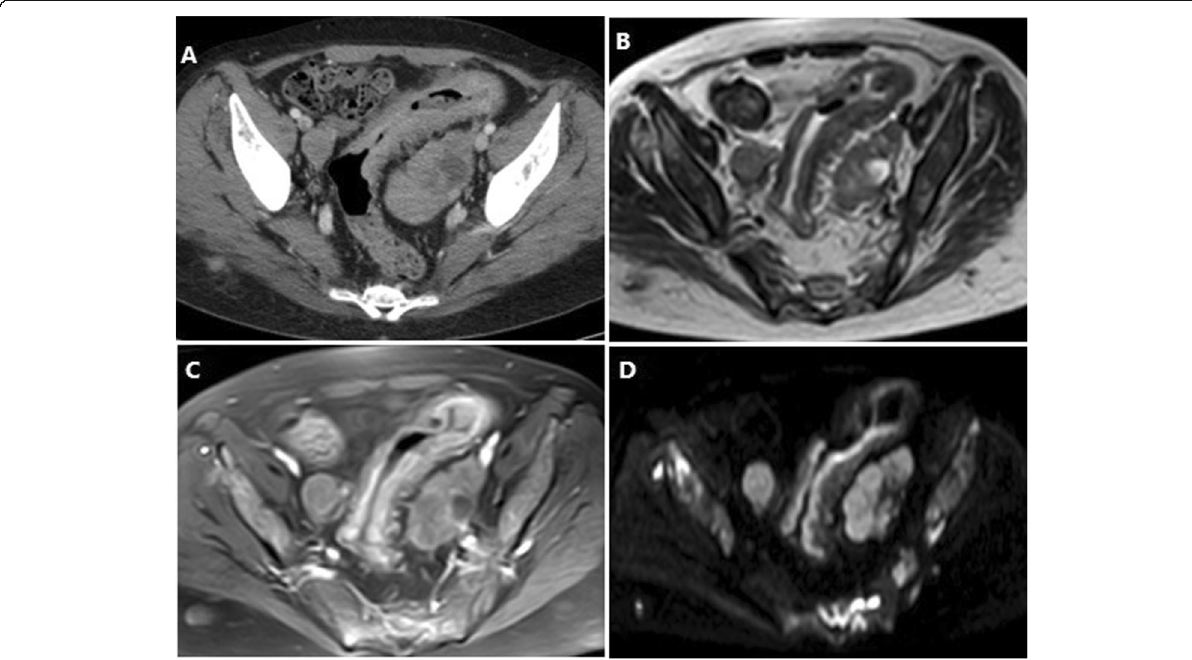
Fig. 2 a Axial post-contrast CT pelvis, b axial T2-weighted image, and c post-contrast T1-weighted image revealed diffuse asymmetrical circumferential thickening of the rectosigmoid with stranding of related fat planes and bilateral predominantly solid complex heterogeneously enhanced ovarian masses, larger on the left side (Krunkenberg tumor). d Axial diffusion-weighted image (DWI) revealed multiple diffusion restricted infiltrative bony deposits at both the iliac bones and sacrum without cortical destruction (missed on CT scan) with better delineation of the diffusion-restricted malignant rectosigmoid infiltration and bilateral Krukenberg